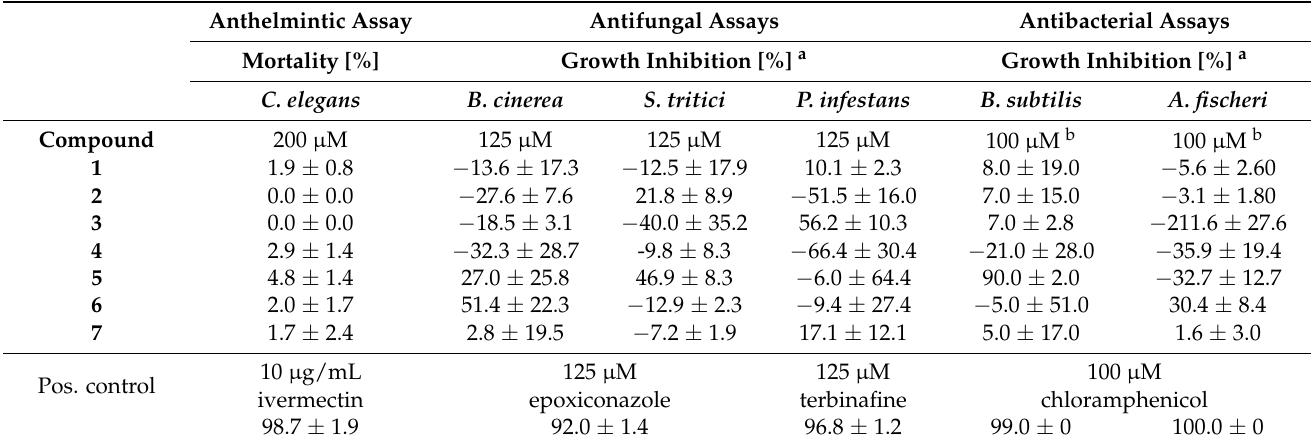
Table 3. Anthelmintic ( Caenorhabditis elegans ), antifungal ( Botrytis cinerea , Septoria tritici and Phytophthora infestans ), and antibacterial ( Bacillus subtilis , Aliivibrio fisheri ) activities of isolated com- pounds ( 1 – 7 ) from P. obtusifolia .